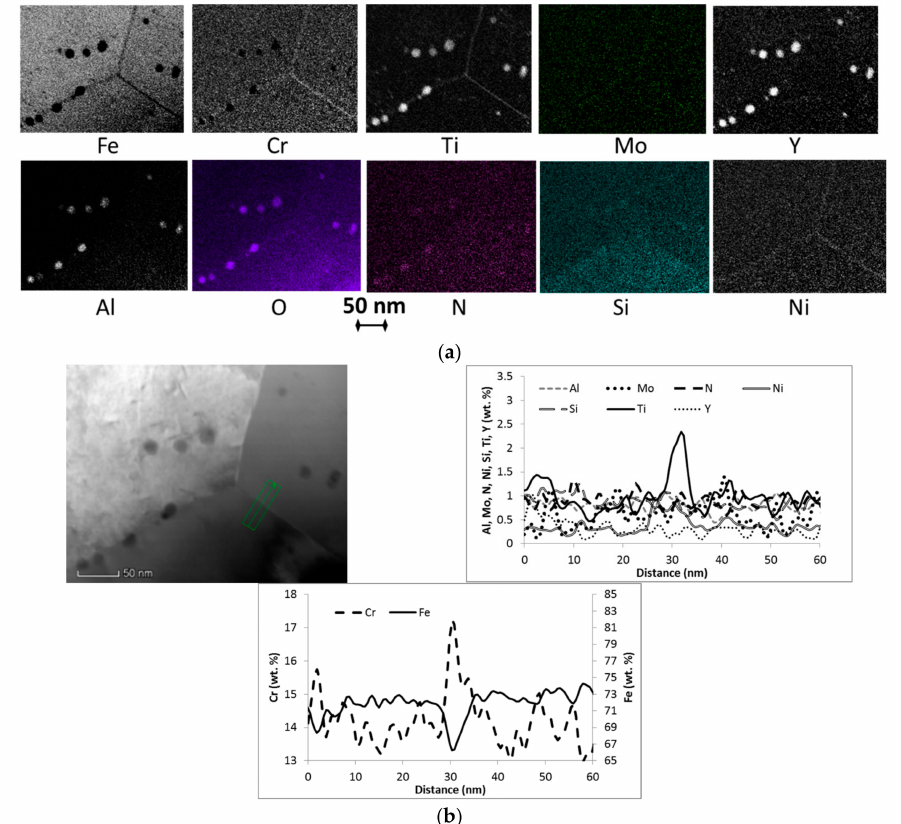
Figure 6. STEM-EDX map and profile of chemical composition across the grain boundary in the He720 condition: ( a ) Maps shows enrichment with Cr, Ti, and slight Ni at the grain boundaries; ( b ) The line shows the high enrichment with Cr and Ti at the grain boundary.